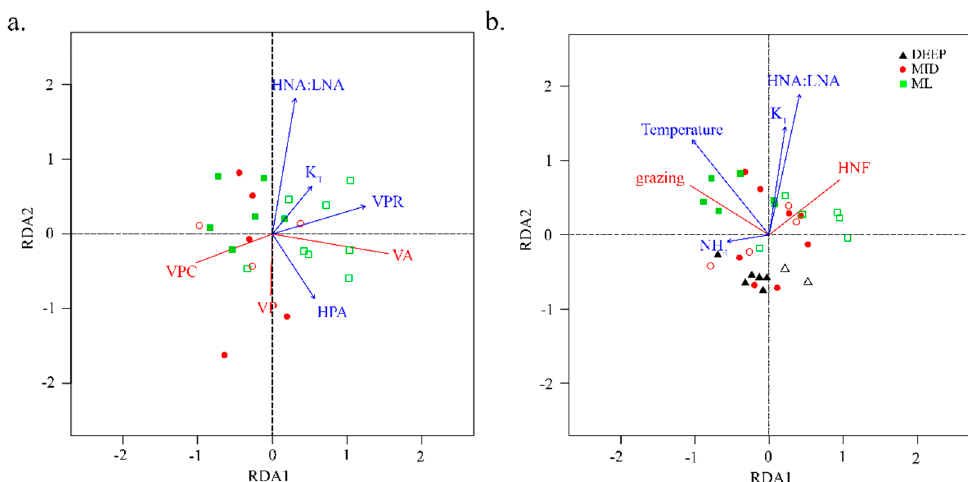
Figure 5. Redundancy analysis (RDA) correlation triplots of factors important in structuring the abundance and activity of mortality agents of ( a ) viruses and ( b ) heterotrophic nanoflagellates during STRATIPHYT. Response variables are shown in red and explanatory variables in blue. Symbols represent individual sampling points (a: n = 22 and b: n = 32) and illustrate from what depth layer samples originated; shape and color coded according to the depth layer and filled according to the presence or absence of a deep ‐ chlorophyll maximum (closed = present and open = absent). The total variance explained by the RDA models in panel a and b were 58.8% and 38.9%, respectively. Abbreviations represent viral abundance (VA), lytic viral production (VP), Mitomycin C prophage induction (VPC), virus ‐ to ‐ prokaryote ratio (VPR), heterotrophic prokaryote abundance (HPA), nitrate (NO 3 ), HNA to LNA ratio (HNA:LNA), ammonium (NH 4 ), vertical mixing coefficient (K T ), and heterotrophic nanoflagellate abundance (HNF).